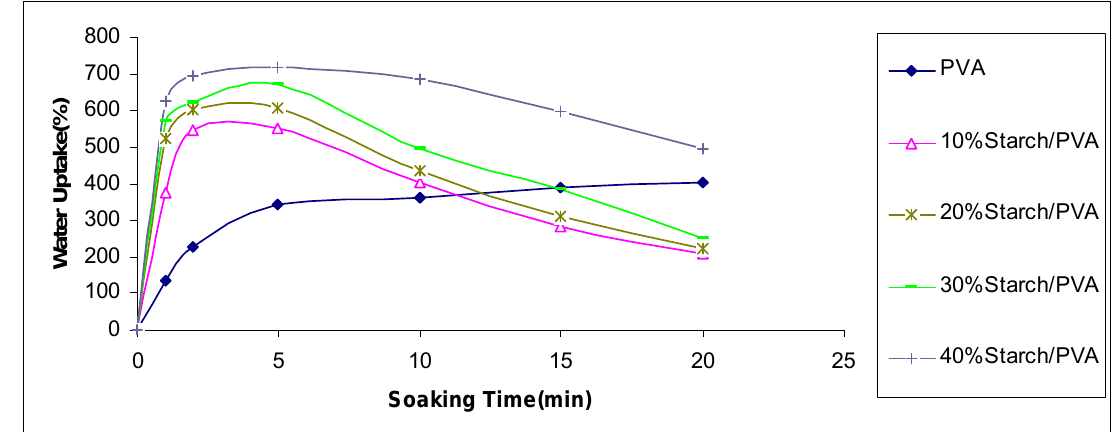
Fig.11: The water uptake relationship with soaking time in water for of PVA, and Starch/PVA at different ratio.